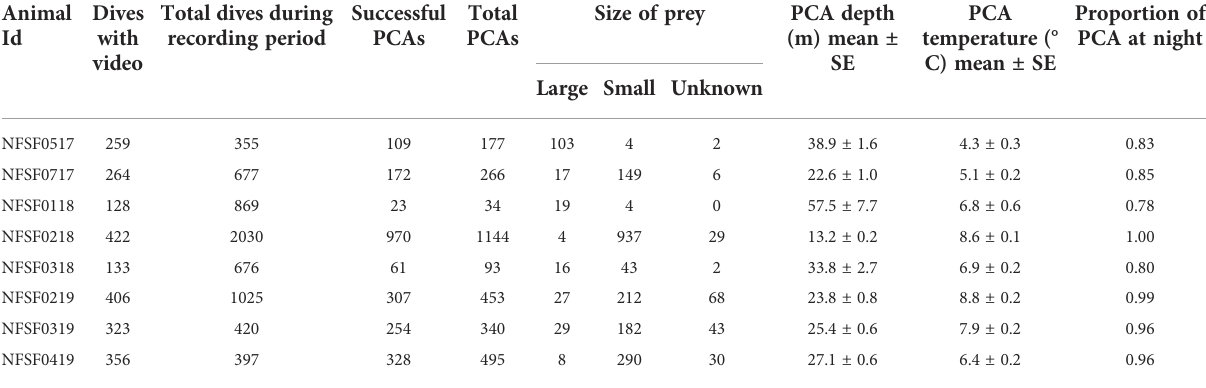
TABLE 2 Dive and prey capture attempt (PCA) metrics during the video recording period for eight northern fur seals tracked in 2017, 2018, and 2019. Animal Dives Id